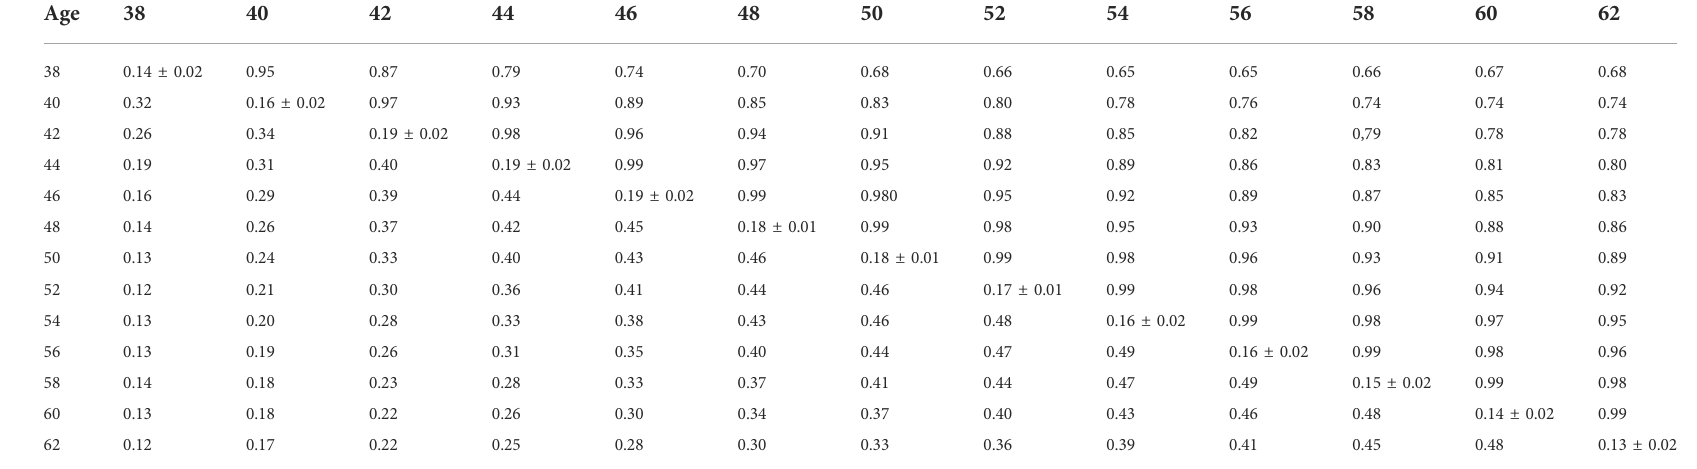
TABLE 10 Estimates of heritability (diagonal), phenotypic correlations (below diagonal), and genetic correlations (above diagonal) for hatch of set (HOS) using the ssGBLUP random regression model.